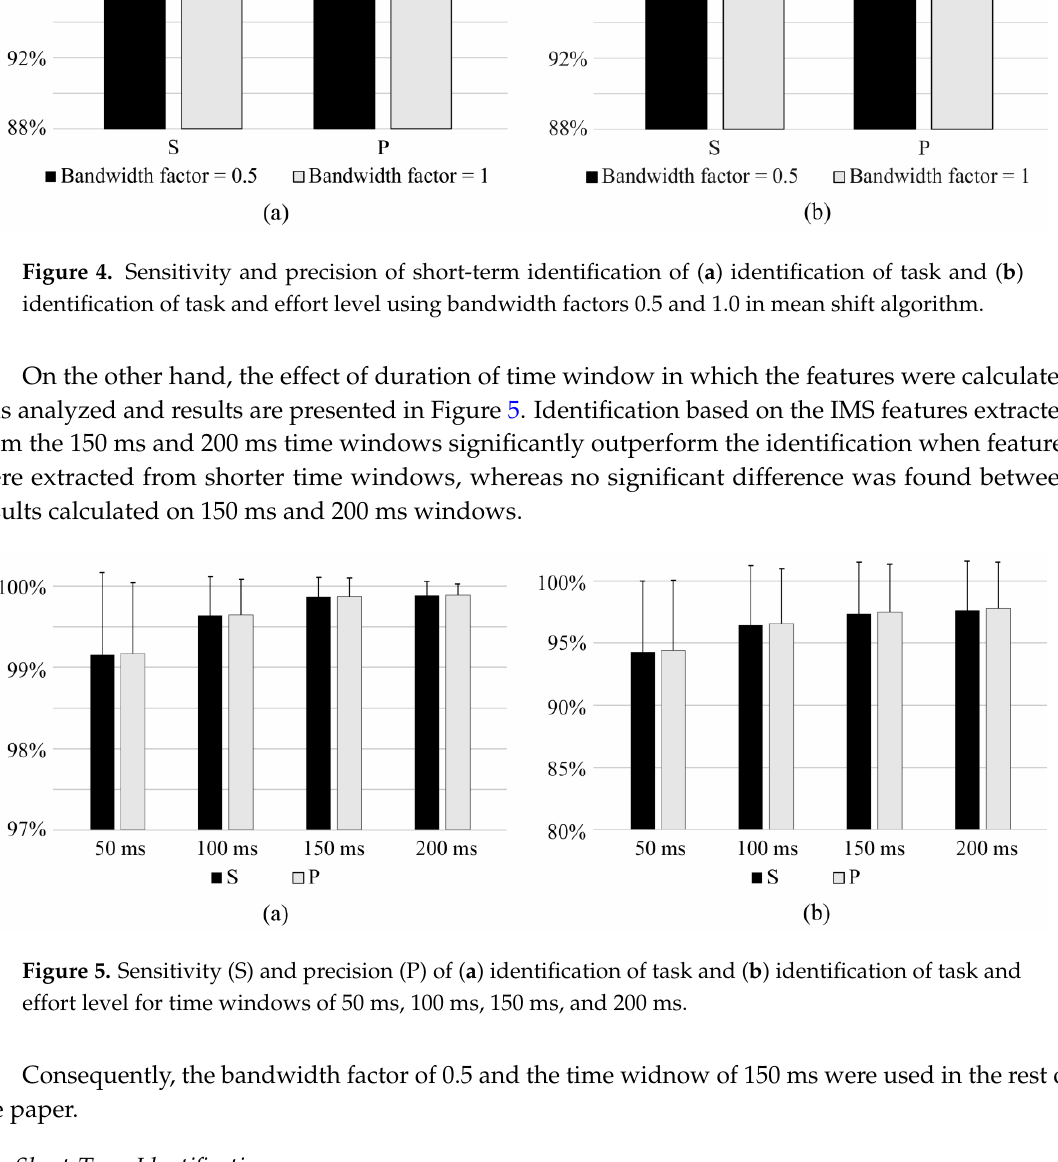
Table 1. Sensitivity and precision of identification of task using IMS features averaged between patients. Identification Indices for each patient were calculated as an average of hold-out repetitions (N = 20) and presented in terms of mean and standard deviation.